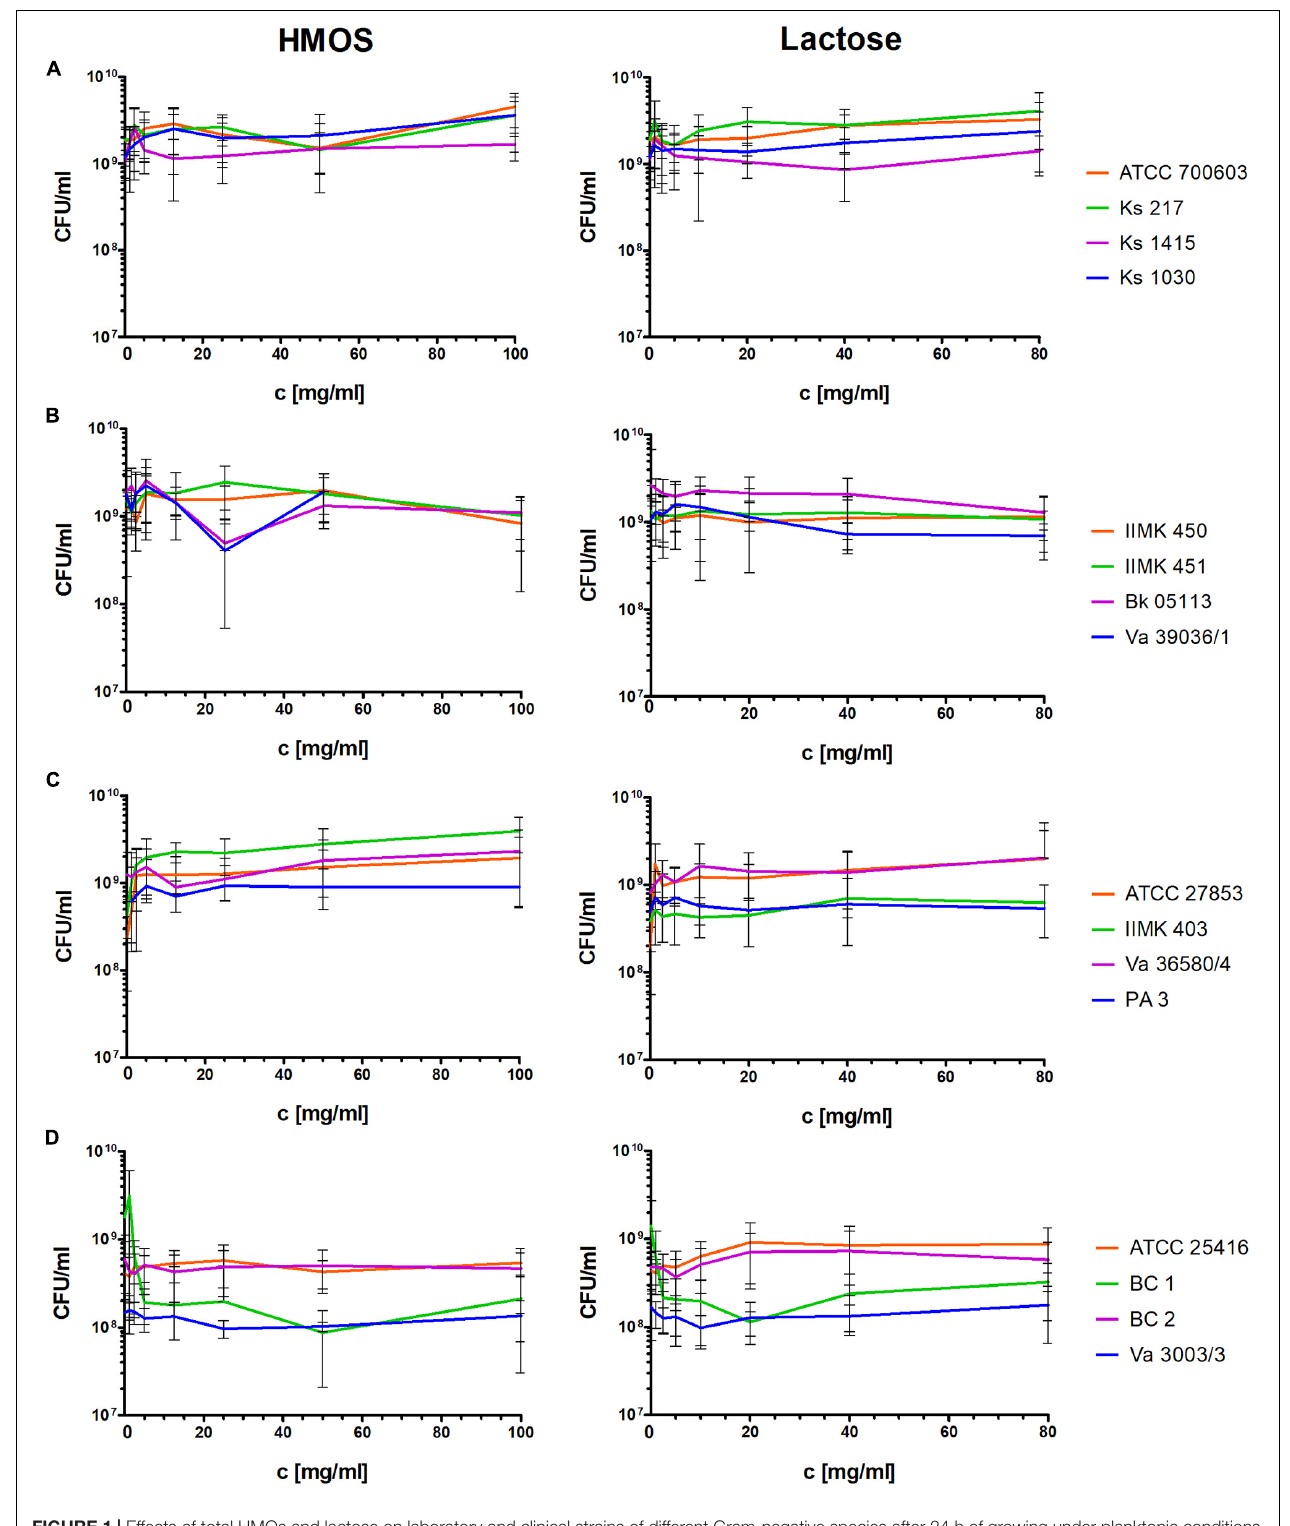
FIGURE 1 | Effects of total HMOs and lactose on laboratory and clinical strains of different Gram-negative species after 24 h of growing under planktonic conditions (assuming that lactose makes up to 80% of the HMOs). (A) K. pneumoniae , (B) A. baumannii , (C) P. aeruginosa , (D) B. cenocepacia .